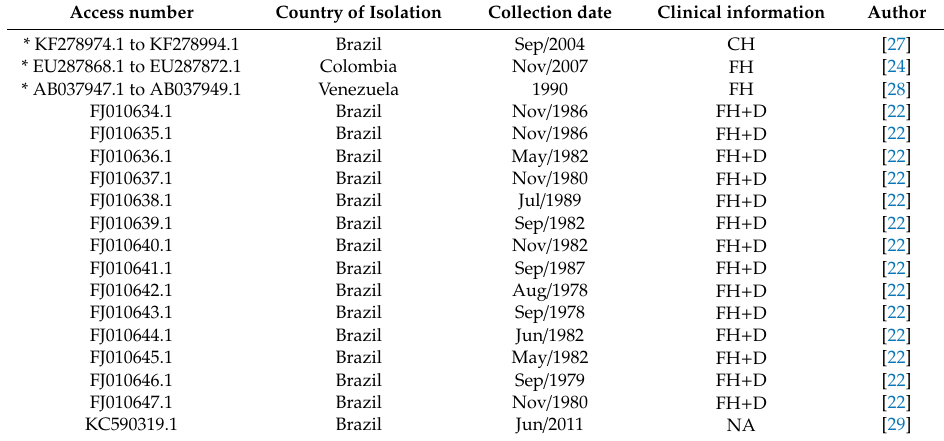
Table 1. Information on the sequences that were used in the